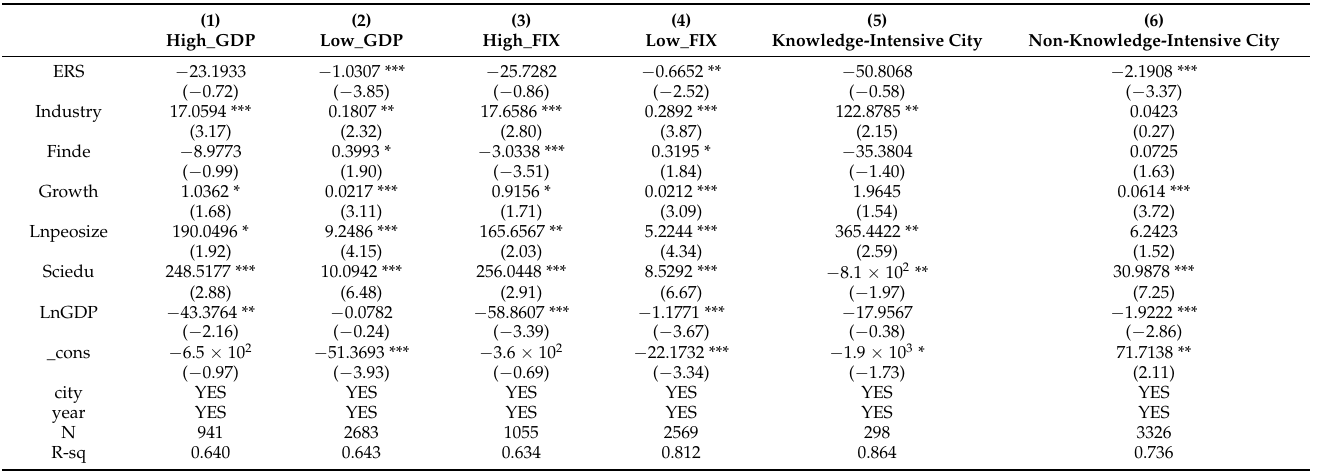
Table 6. Robustness test results of regional economic development, fixed investment and knowledge- intensive city.